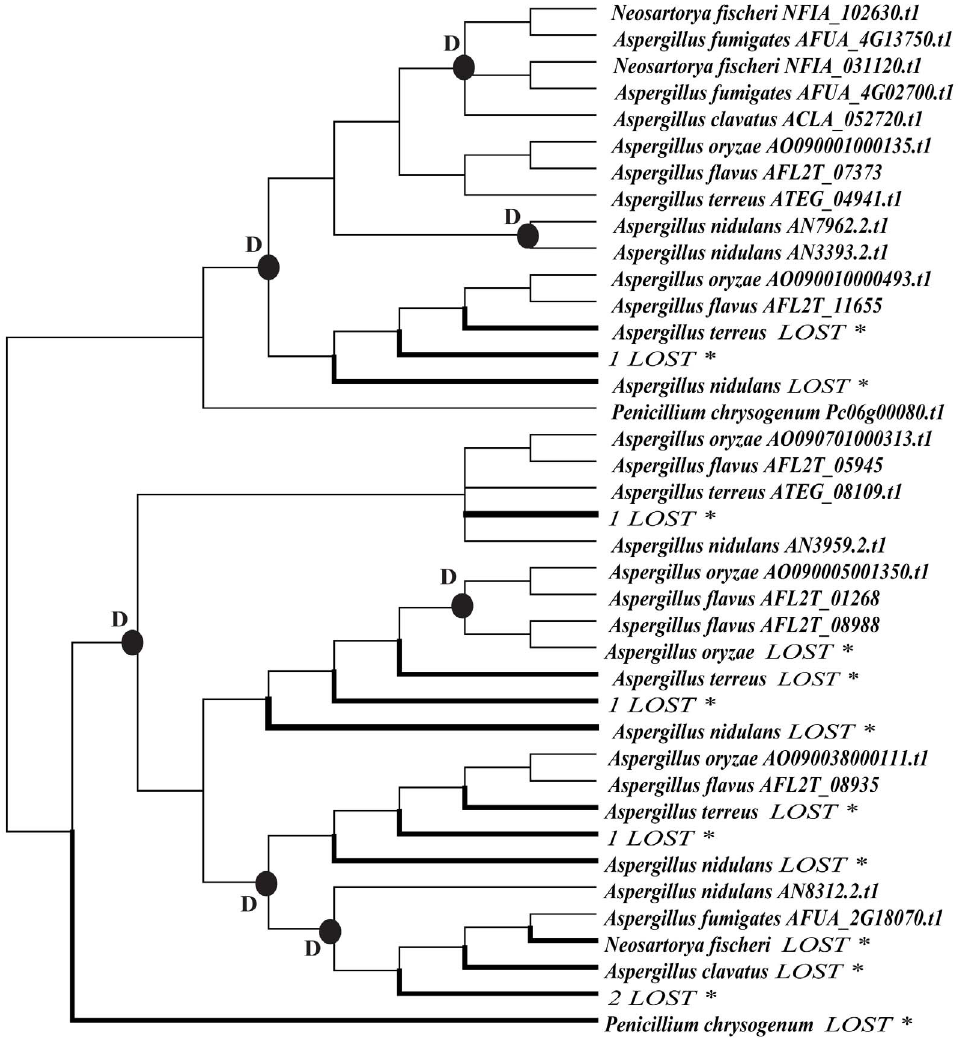
Figure 4. Duplication and loss events of M35 family genes in Eurotiales fungi. The reconciliation between species tree and gene tree of Eurotiales fungi along with the confirmation of the gene loss/duplication scenario were determined by using Notung 2.6 [21]. The species tree of Eurotiale fungi is shown as Fig. S8. Putative duplication events are indicated with solid cycles, while loss events are indicated with thick branches. 1, the lineage includes species of A. fumigatus, N. fischeri and A. clavatus . 2, the lineage includes species of A. nidulans , A. terreus, A. oryza and A. flavus